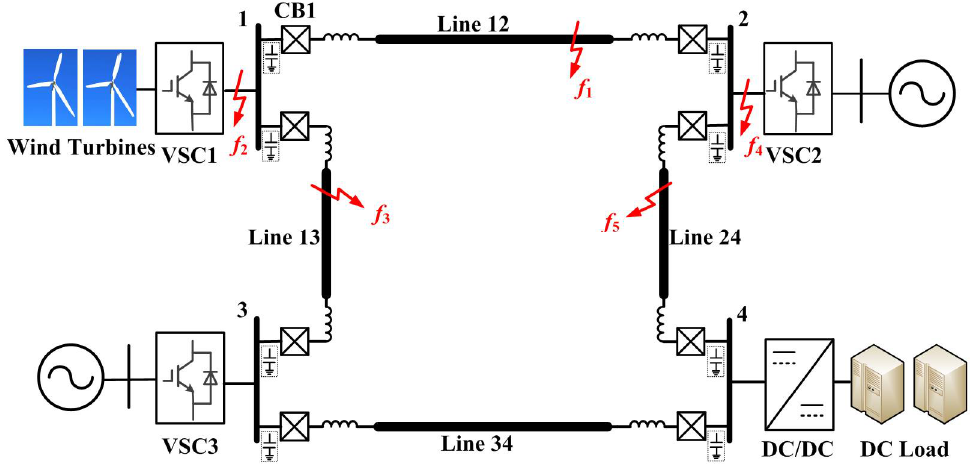
Figure 6. Voltage source converter (VSC)-based DC microgrid system.